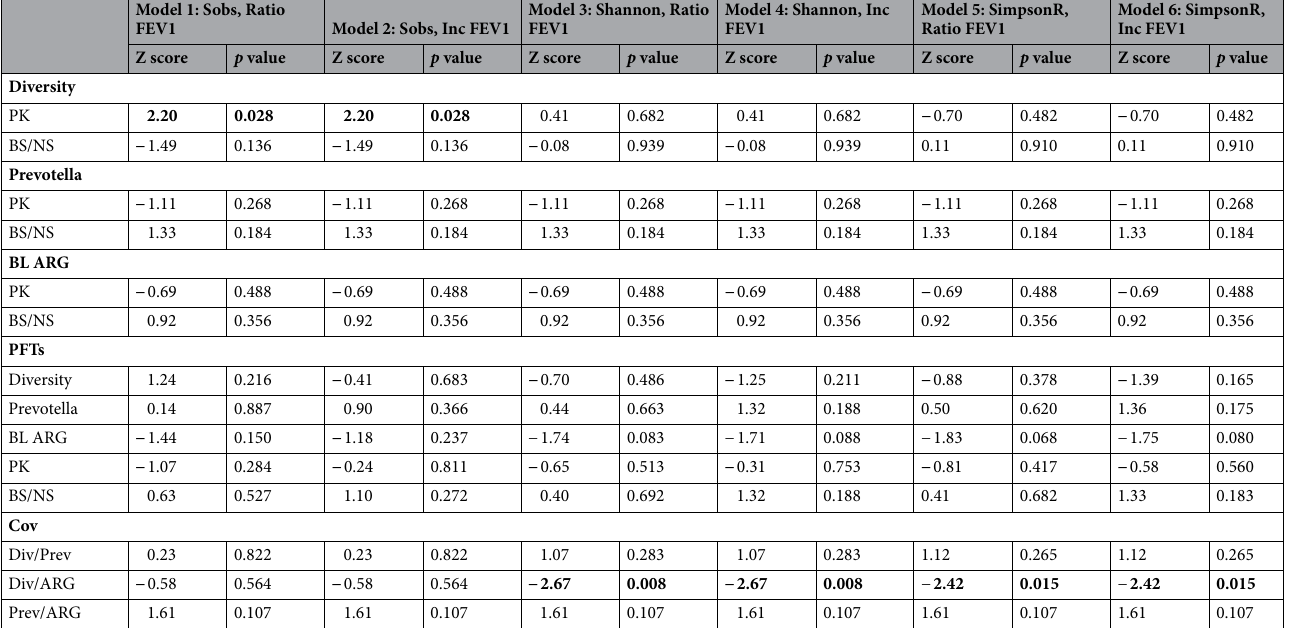
Table 2. Structural equation modeling results. BL Beta-lactam; ARG Antibiotic resistance genes; PFTs Pulmonary function tests; Cov Covariance; PK Pharmacokinetics; BS / NS Broad spectrum versus narrow spectrum; Prev Prevotella sp.; Sobs Species observed; SimpsonR Inverse Simpson index; Ratio FEV1 Ratio of the percent predicted forced expiratory volume in one second (ppFEV1) at end of treatment compared to the best ppFEV1 in the prior 6 months; Inc FEV1, increase in ppFEV1 at the end of treatment compared to pulmonary exacerbation onset. Significant values are in